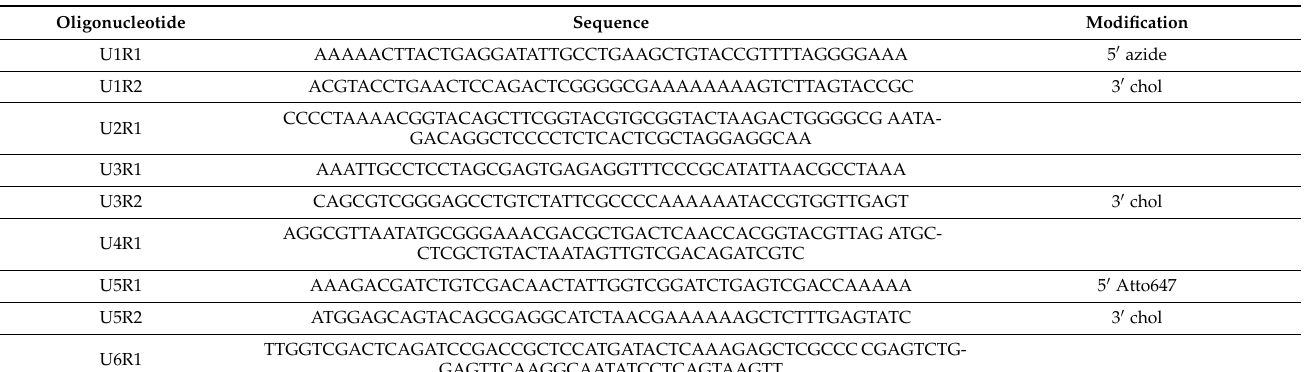
Table A1. Sequences of oligonucleotides used in 6-helix DNA nanotube assembly. All conjugated oligonucleotides were purified using